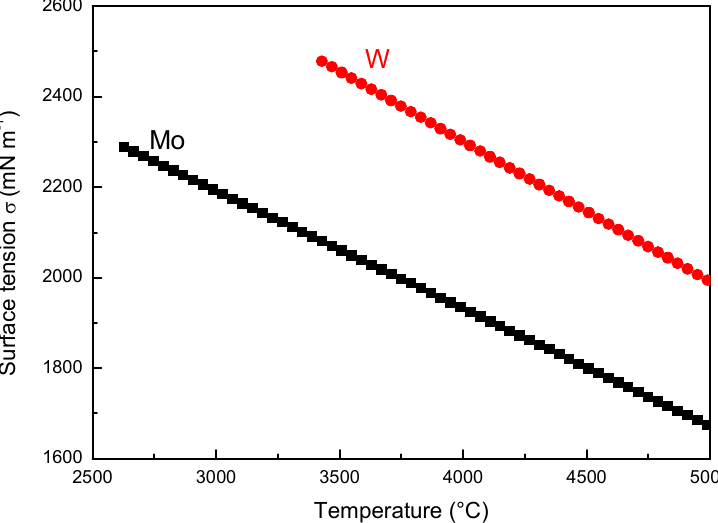
Figure 7. Surface tension of W and Mo vs. temperature, calculated according to the relationships of Paradis et al. [33,34].